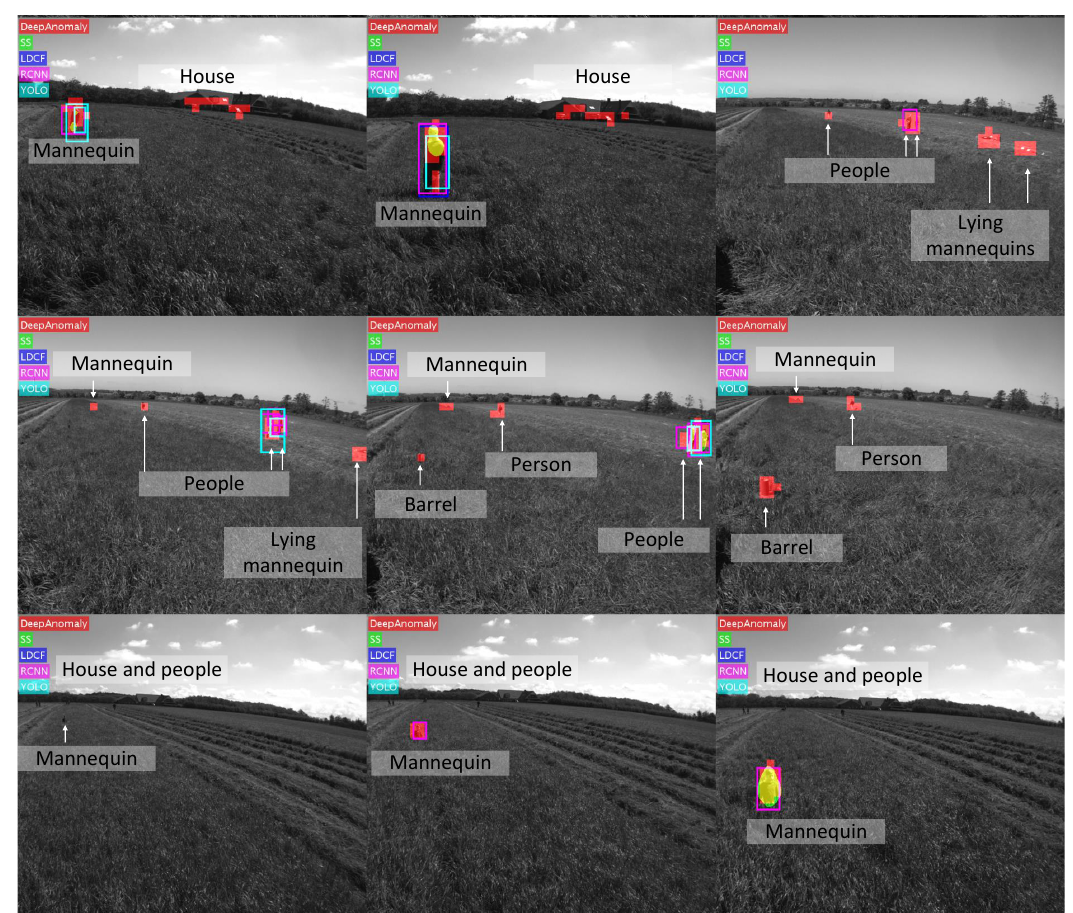
Figure A2. Detection examples of 15 image with